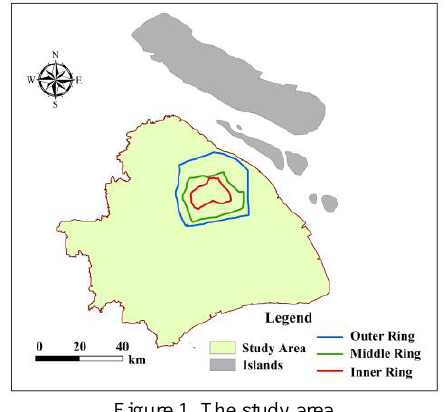
Figure 1. The study area.